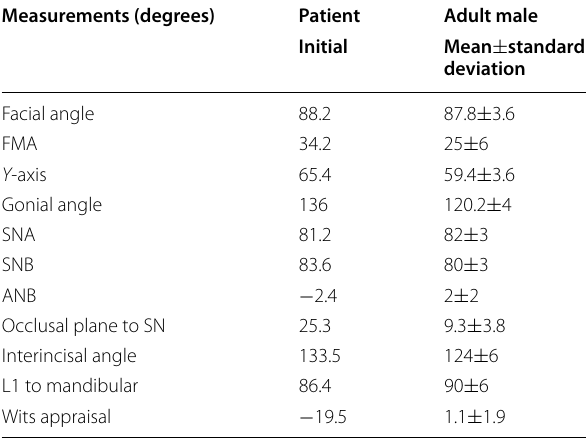
Table 3 Preoperative analysis results: case